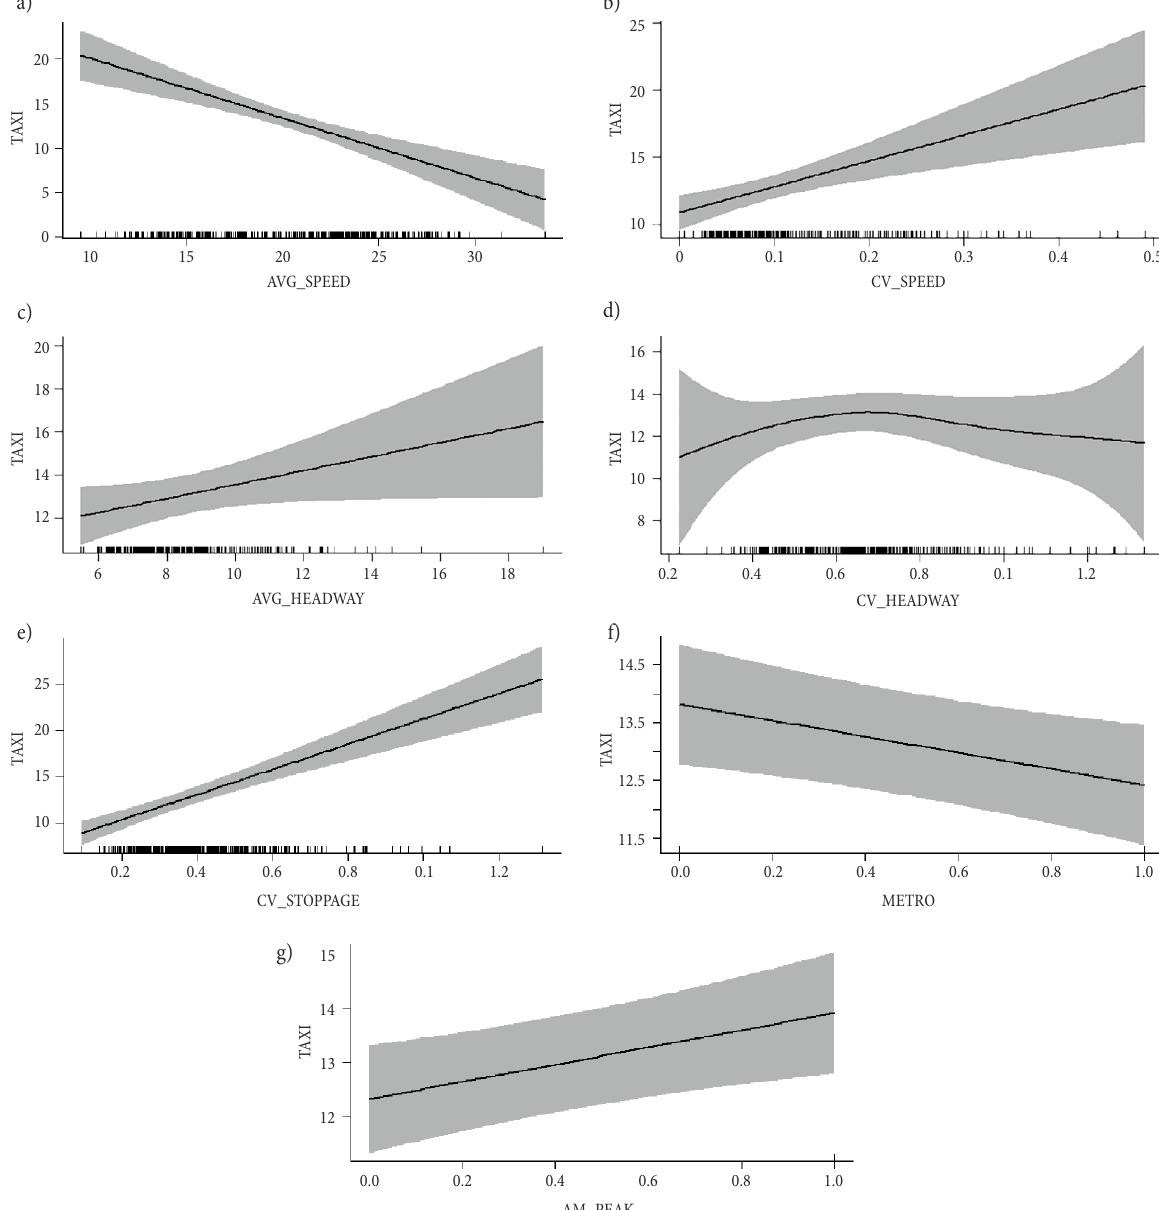
Figure 4. Fitted components of the semiparametric model: a – smooth function of mean bus speed; b – smooth function of coefficient of variability (CV) of bus speed; c – smooth function of mean bus headway; d – smooth function of CV of bus headway; e – smooth function of CV of bus stoppage time; f – smooth function of metro; g – smooth function of morning peak (the shaded area are the estimated 95% confidence intervals; the vertical lines adjacent to the lower x -axis show the presence of data in